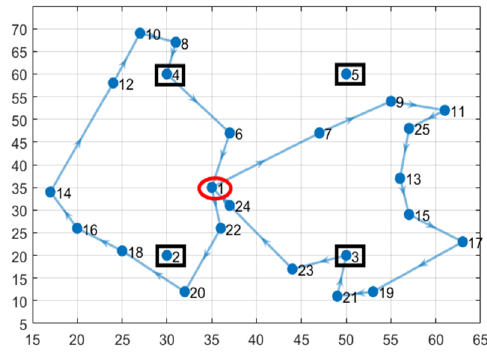
Figure 9. Routes of the best solution (instance 1).